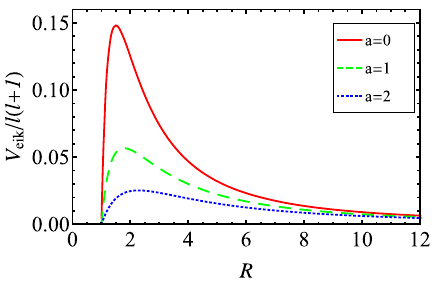
Fig. 1 The eikonal part of the effective potential V eik = V for a dyon black hole solution. Left panel: The reduced (eikonal) effective potential V / l ( l + 1 ) as a function of R . Right panel: The reduced (eikonal) effective potential V / l ( l + 1 ) as a function of R ∗ . In both